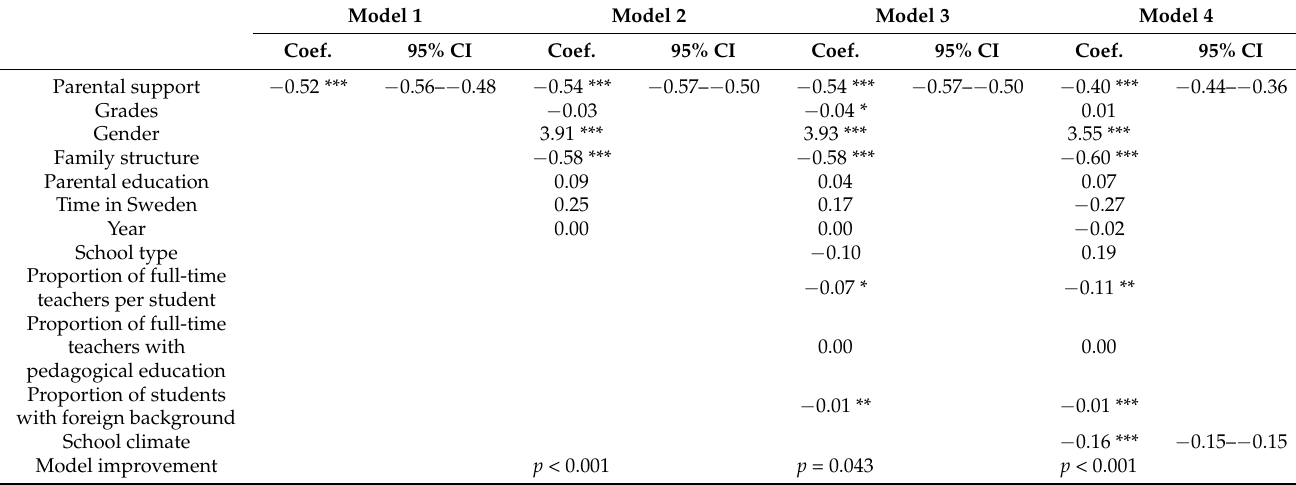
Table 3. Linear regression analyses of psychological complaints ( n = 5783 students distributed over 152 schools). Model 1 Model 2 Model 3 Model 4 Coef. 95% CI Coef. 95% CI 95%